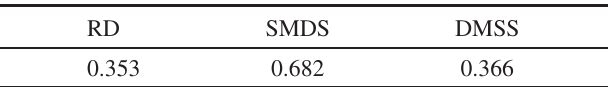
TABLE IV. Noncharacteristic undefined scheme threshold values. Each value represents how much the pointlike and setlike probabilities of a response must differ in order to be classified as pointlike or setlike, as opposed to undefined.